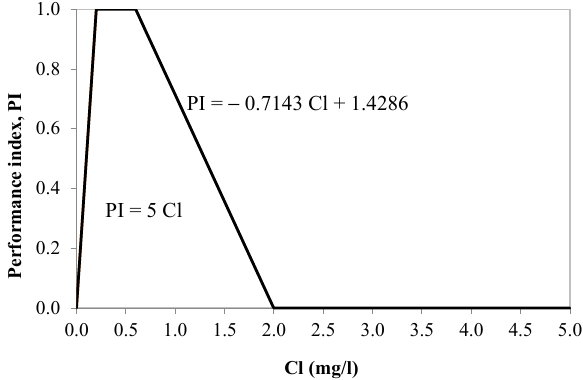
Figure 2. Proposed free chlorine performance function for drinking water distribution systems described by Equation (4).